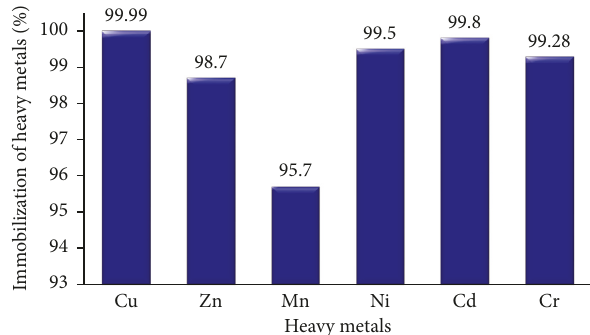
Figure 7: Heavy metal immobilization in 2g of soil at pH 6.58 using 5mL of